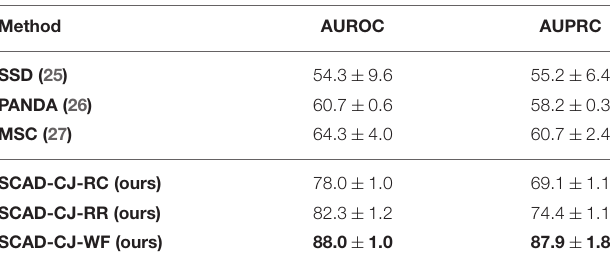
TABLE 2 | Results evaluated by AUROC% and AUPRC%.